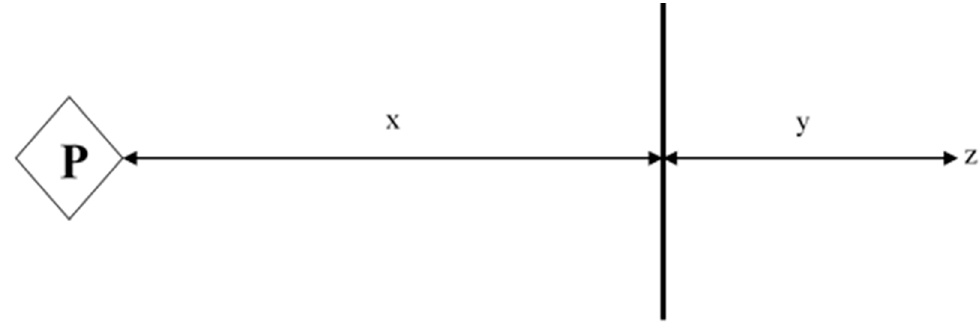
Figure 2. Schematic layout of the method used to select a sampling site—where the diamond denoted with a ‘P’ represents the post (landward), ‘x’ represents the distance from the post to the king tide mark, the solid vertical line represents the king tide mark, ‘y’ represents the 5-m distance below the king tide mark, and ‘z’ represents the sampling site (seaward).